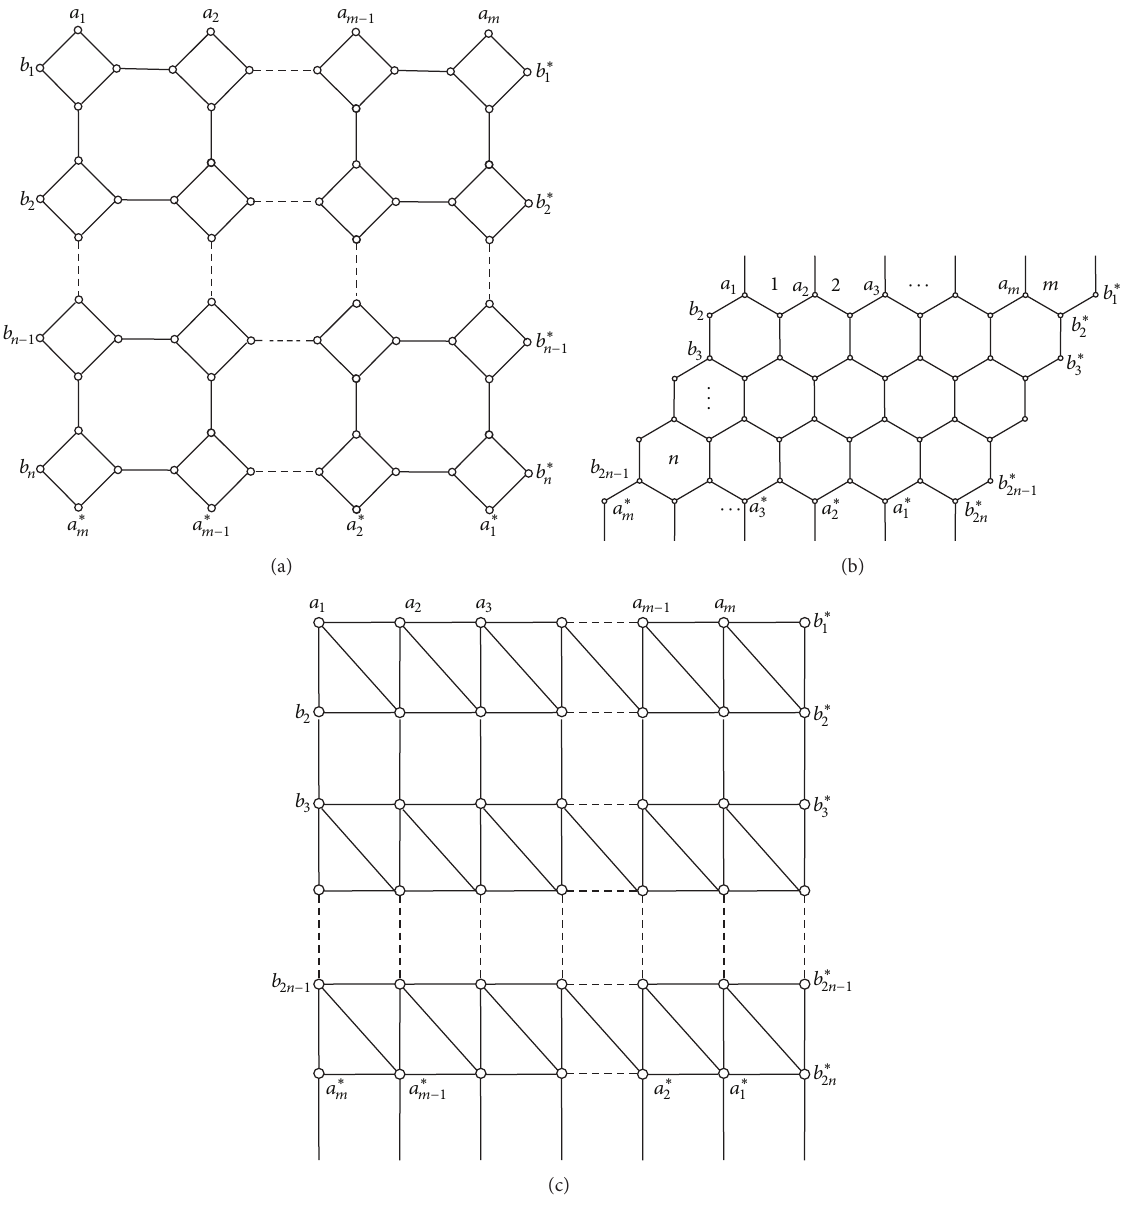
Figure 1: (a) The 4.8.8 lattice; (b) the hexagonal lattice; (c) the 3 3 ⋅ 4 2